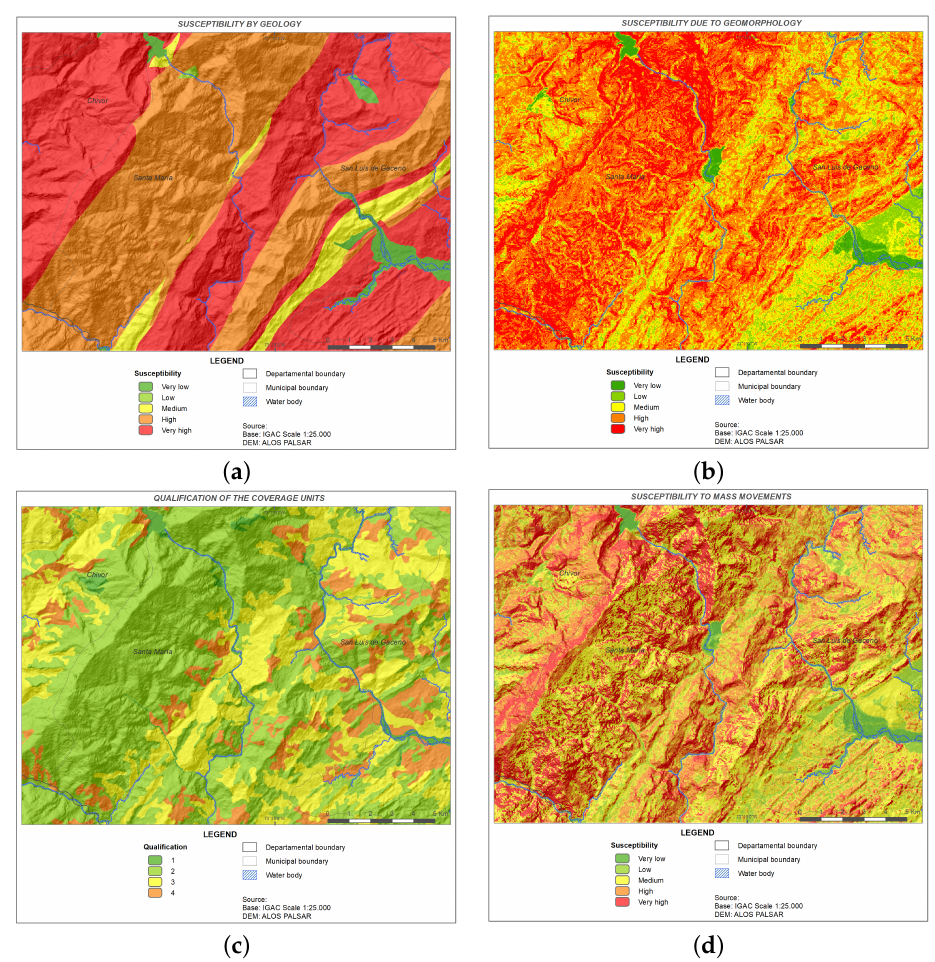
Figure 4. Inputs and final ground truth map for the study area. ( a ) Map of susceptibility by geology; ( b ) map of susceptibility by geomorphology; ( c ) coverage unit qualification map; ( d ) landslide movement susceptibility